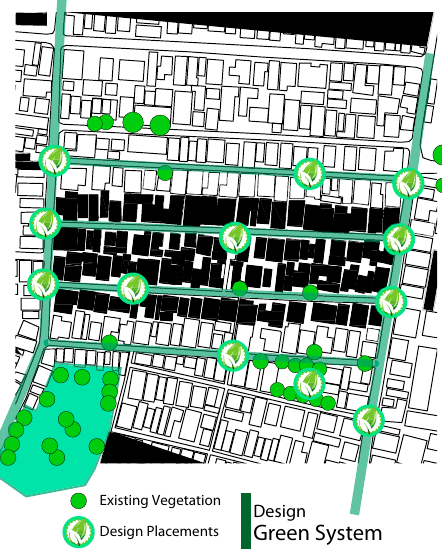
fig. 9. Suggested placement for the designed object (created by the